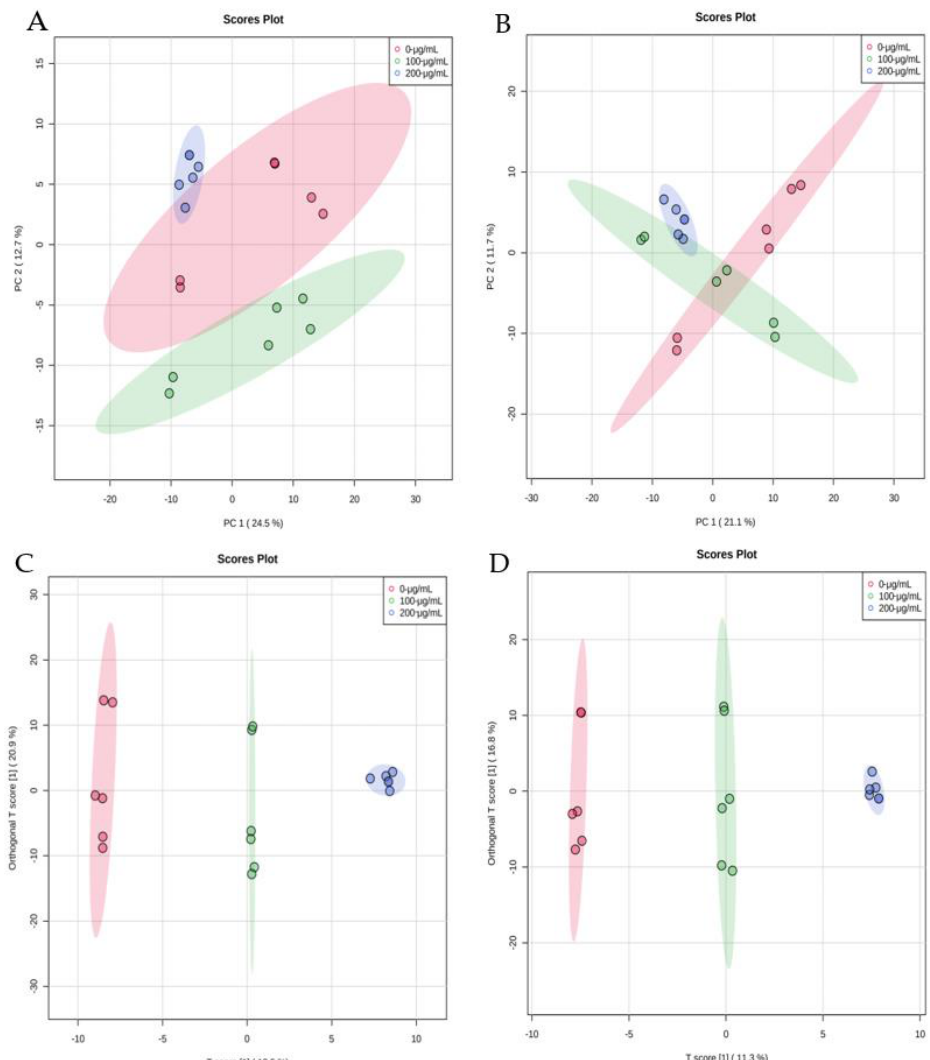
Figure 4. PCA score plots based on the UPLC-HRMS data of CV-treated groups and the control group in the positive mode ( A ) and in the negative mode ( B ), and OPLS-DA score plots of CV-treated groups and the control group in the positive mode ( C ) and in the negative mode ( D ).